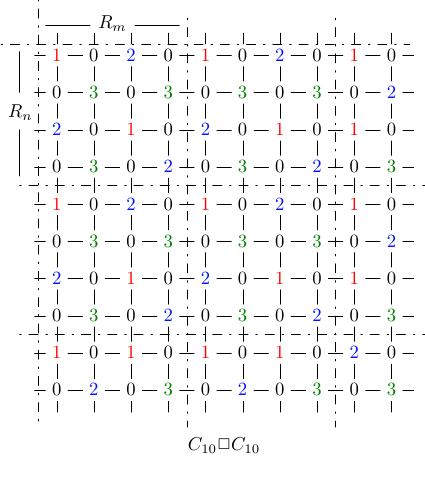
Figure 7. f on C 10 2 C 10